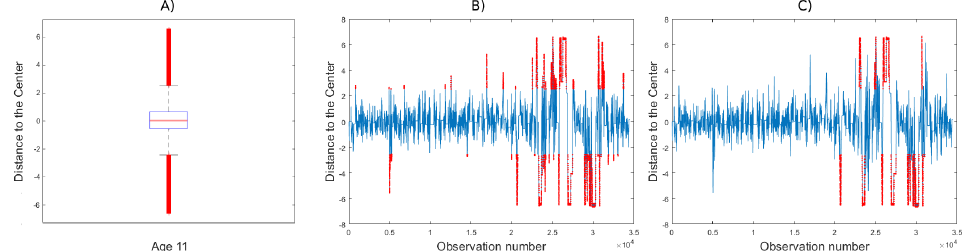
Figure 4. Example of attention span analysis of participant 11-6. ( A ) Boxplot of distance to the center of 11-year-olds to determine outliers. ( B ) Graph showing in red outlier positions of the car in participant 11-6’s recorded trajectory. ( C ) In this graph, only errors that were sustained for more than one second are colored in